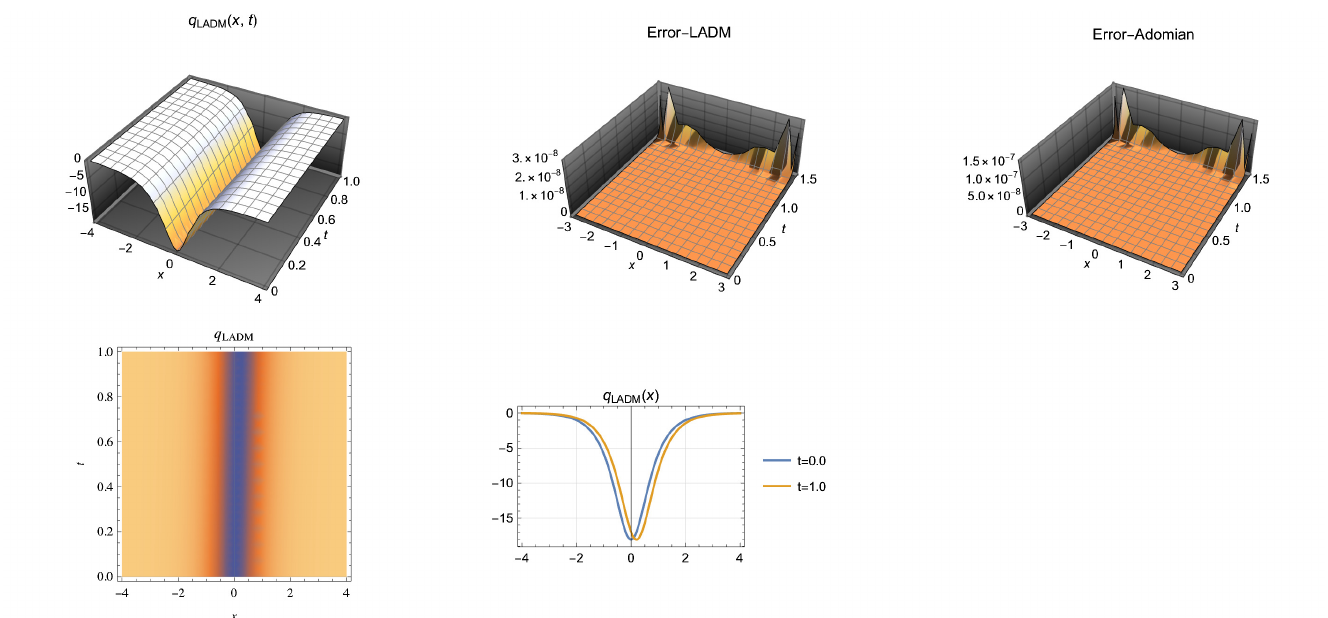
Figure 3. Soliton profile q LADM ( x , t ) in the interval − 4.0 ≤ x ≤ 4.0, for the parameters selected in Case 3 ( above left ). Error by LADM ( above center ) and error by Adomian method ( above right )). Density graph ( bottom left ). Two dimensional (2D) graph for t = 0.0 and t = 1.0 ( bottom right ).